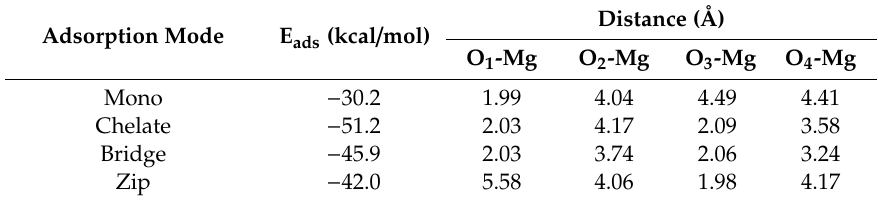
Table 2. Adsorption energies (E ads ) and O-Mg distances of salicylate donor (SID-4) adsorbed on the pre-activated MgCl 2 (110) surface with four di ff erent adsorption modes.